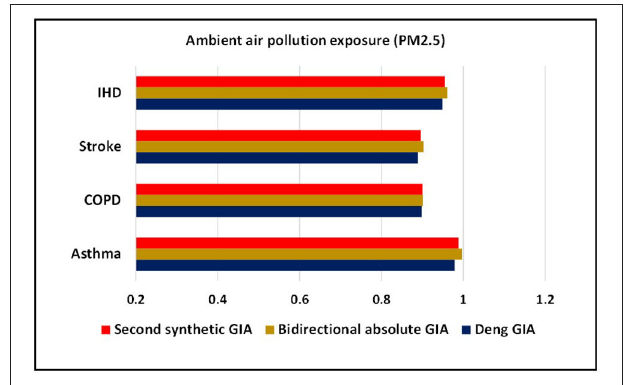
FIGURE 2 | Comparative assessment of ambient air pollution exposure based on grey incidence analysis